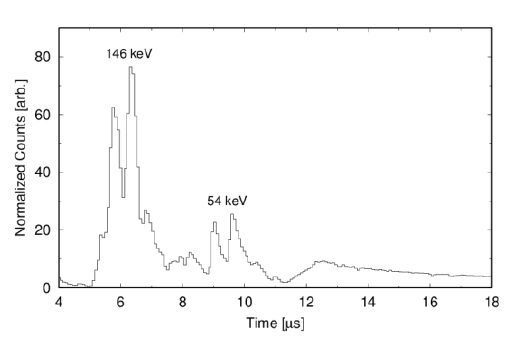
Fig. 4. Neutron TOF spectrum of neutron beam filtered with the 20-cm thick Si